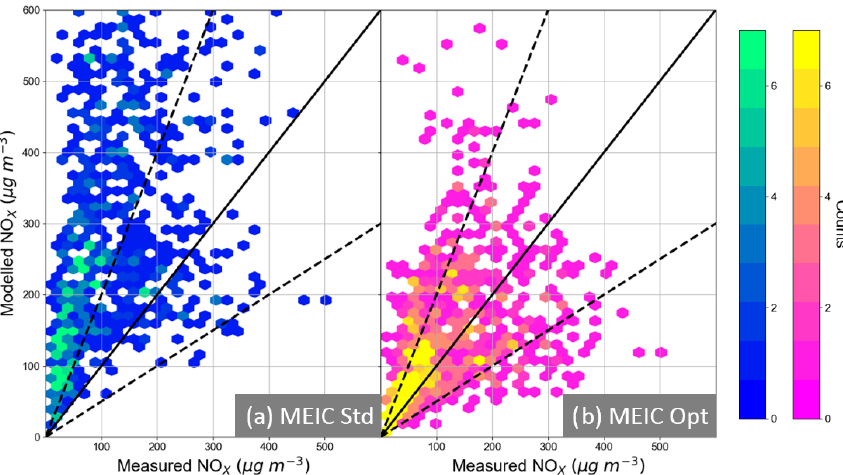
Figure 6. Hourly measured and modelled NO x concentrations during the campaign period at the IAP field site. Panels (a) and (b) show concentrations simulated using MEIC Std and MEIC Opt, respectively. Colours represent the total number of matching hourly measured and modelled values contained within distinct hexagonal bins. Dashed lines mark a factor of 2 difference between measured and simulated